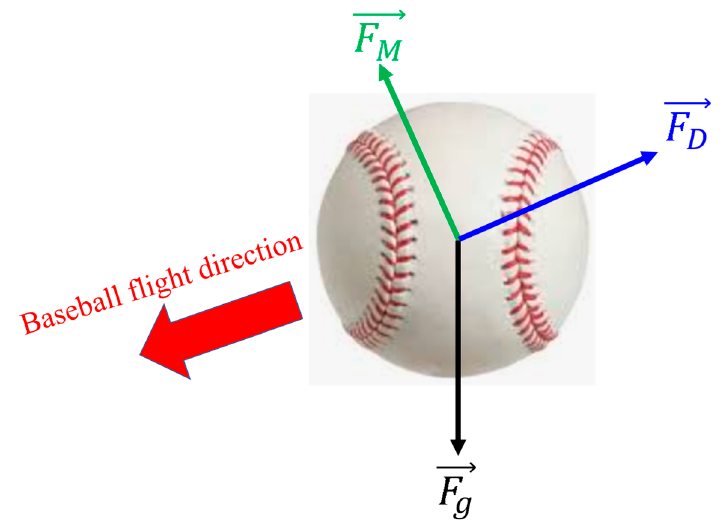
Figure 1. Force analysis during baseball